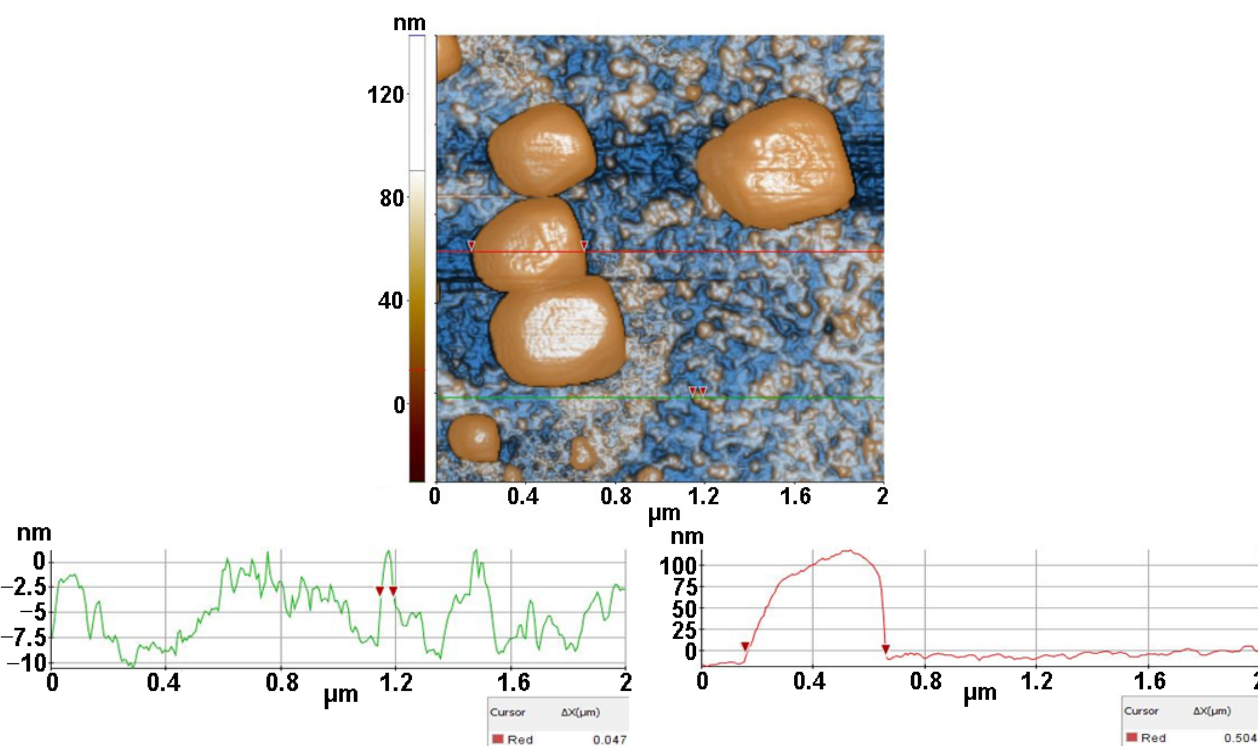
Figure 8. Two-dimensional AFM image of MC ( M. lysodeikticus from bacterial inoculum) with TiO 2 deposited on glass substrate, recorded at the scale of (2 μ m × 2 μ m) with two characteristic surface profiles (red and green line scans).